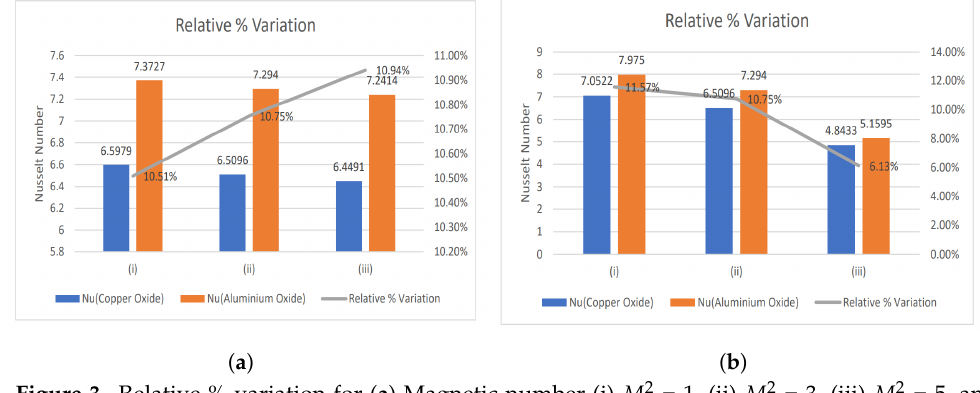
Figure 3. Relative % variation for ( a ) Magnetic number (i) M 2 = 1, (ii) M 2 = 3, (iii) M 2 = 5, and